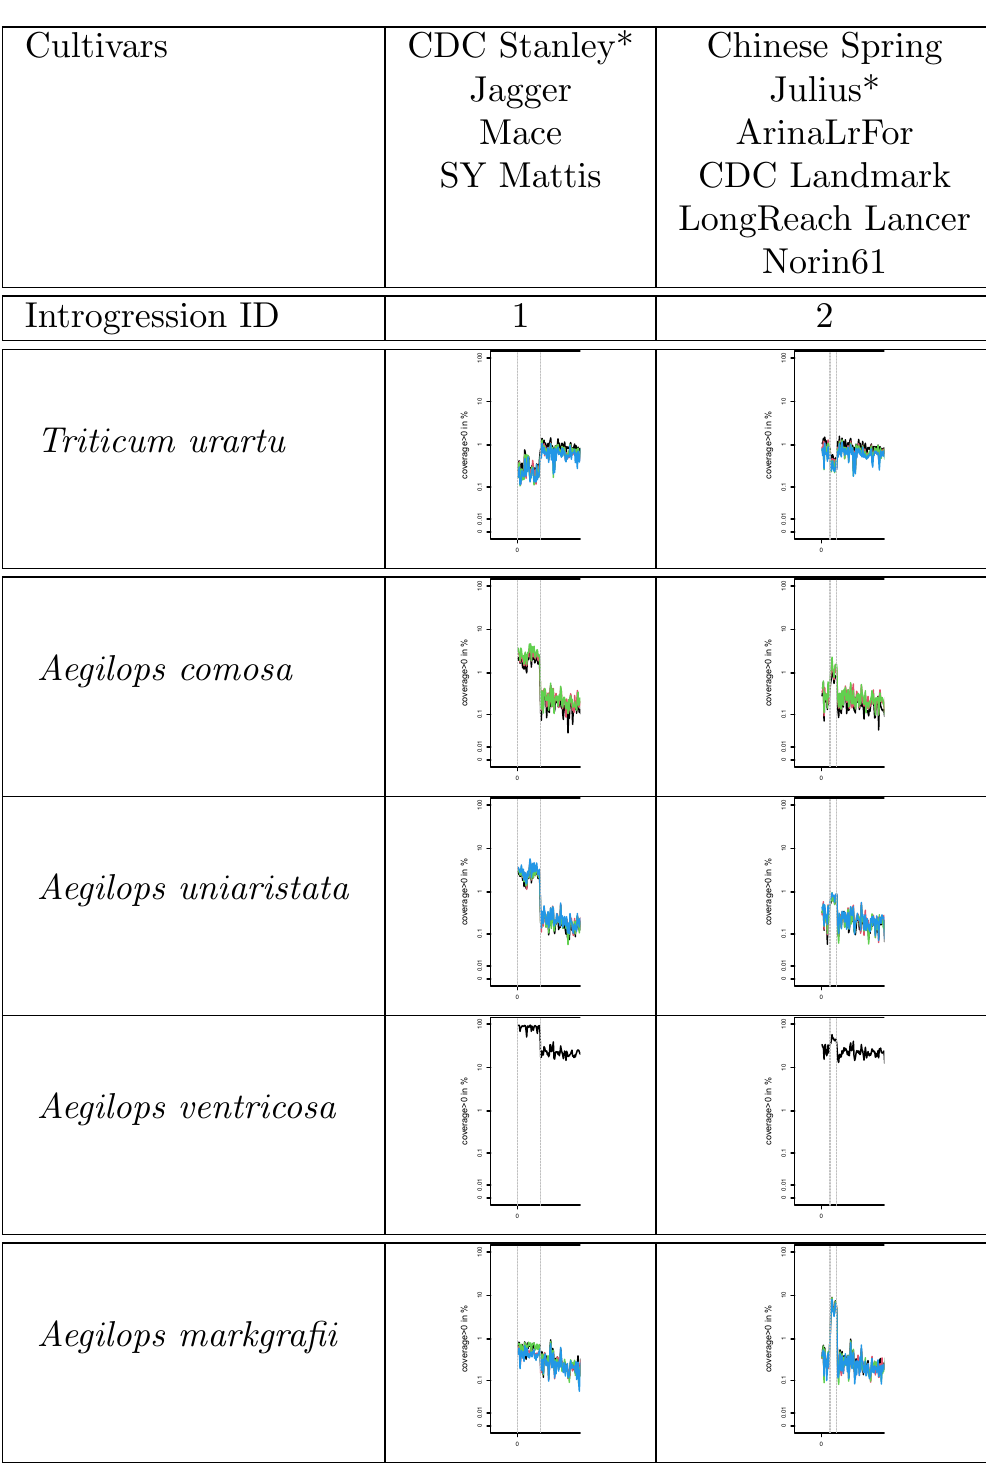
Figure 3. Introgressions on chromosome 2AS (introgressions 1 and 2). Figure shows two clusters of cultivars with two different introgressions, each depicted in one column. In both cases, we detected a region with low coverage of reads from the A-subgenome donor Triticum urartu and high coverage of reads from the putative donor species. The cultivars marked with an asterisk were used as the reference genome in the corresponding